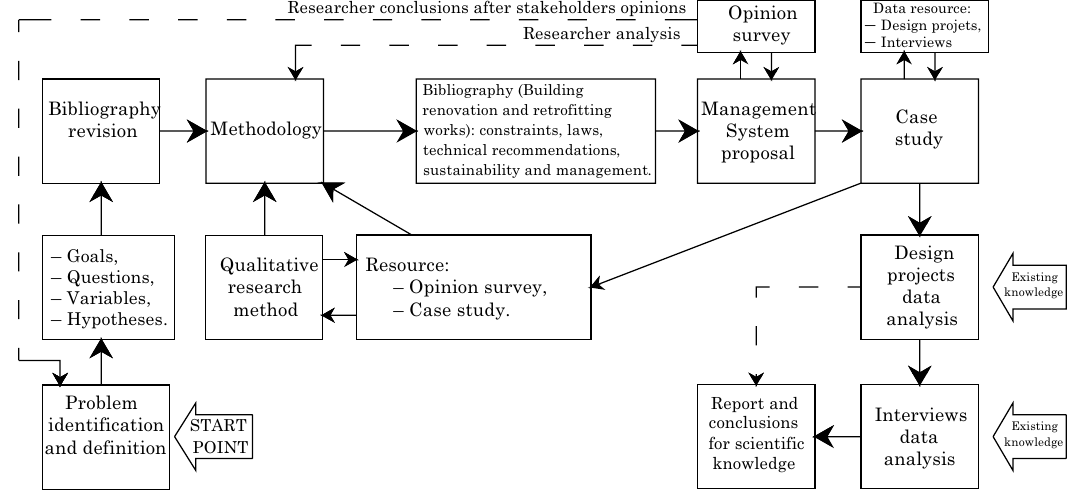
Fig. 1. Research methodology (adapted from Fellows, Liu